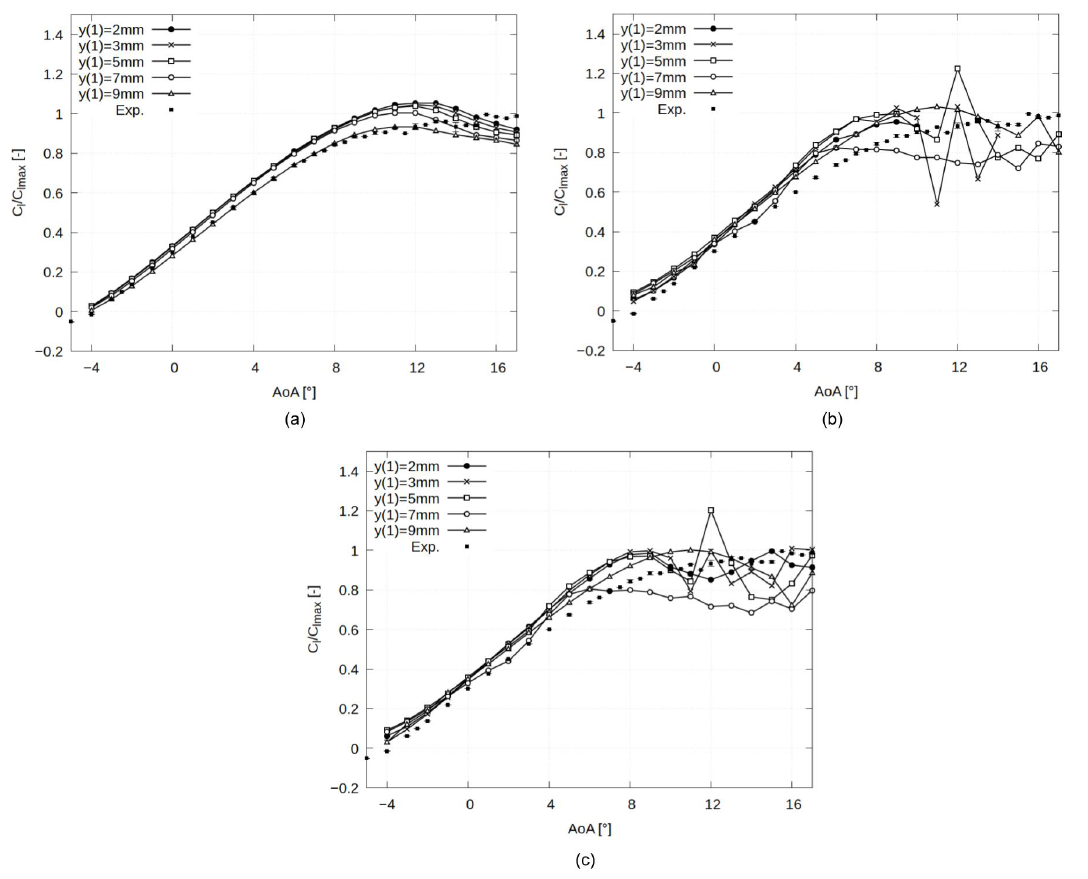
Figure A1. C l vs. AoA of profile 1 for different first cell heights y ( 1 ) using ( a ) Momentum, ( b ) DLR, and ( c ) Colebrook